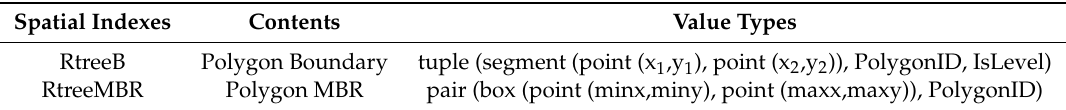
Table 4. R-tree for polygon